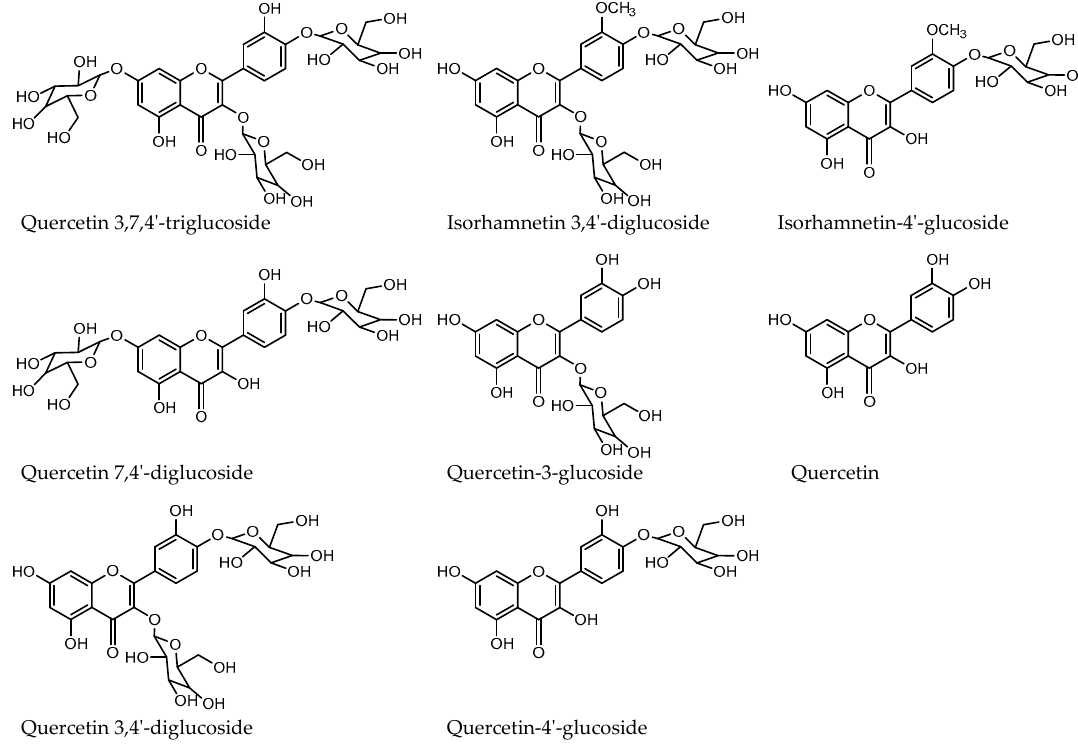
Figure 6. Structure of identified flavonoids from red onion. Table 3. Quantification of flavonoids and anthocyanins in red onions by HPLC. Phytochemical